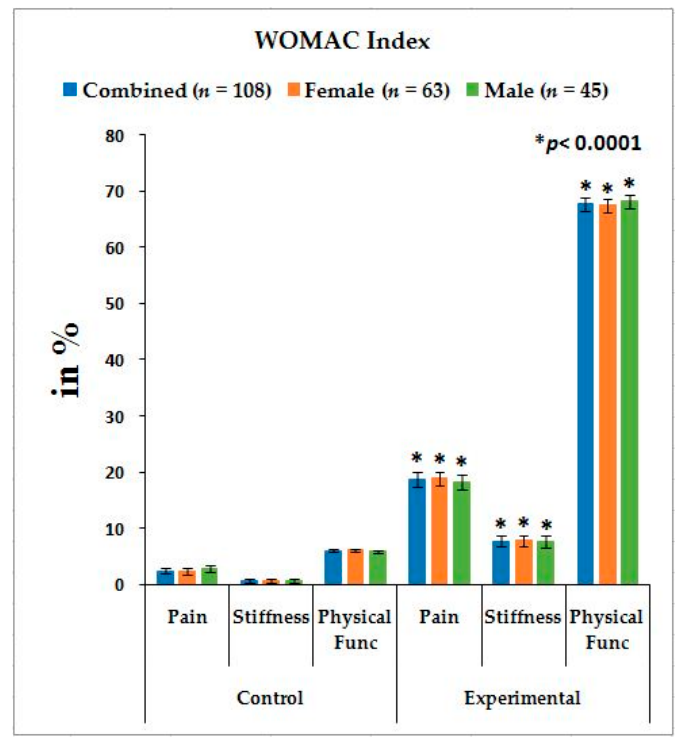
Figure 1. Graphical representation of international acclaimed pain outcome measurements under Western Ontario and McMaster Universities Osteoarthritis Index (WOMAC) Index in comparison with control and experimental groups and their p -values.